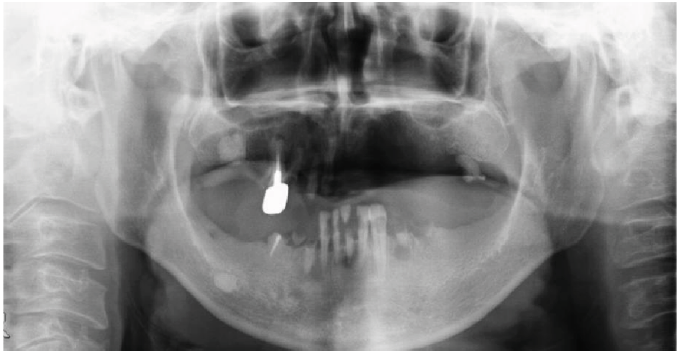
Figure 2: Panoramic X-ray photo. There are few teeth in his mouth, and he has di ffi culty